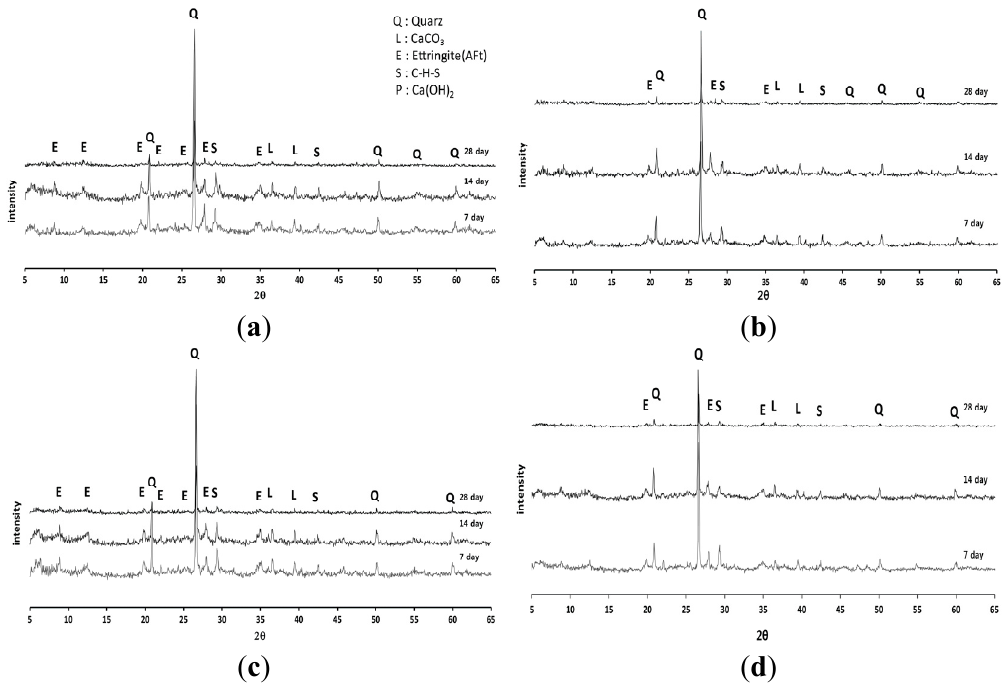
Figure 7. Comparison of XRD diffractogram of mixtures with the types of admixtures at 15% mixing ration of solidification agents. ( a ) OPC; ( b ) OPC + OSP; ( c ) OPC + SMS; ( d ) OPC + FGD.